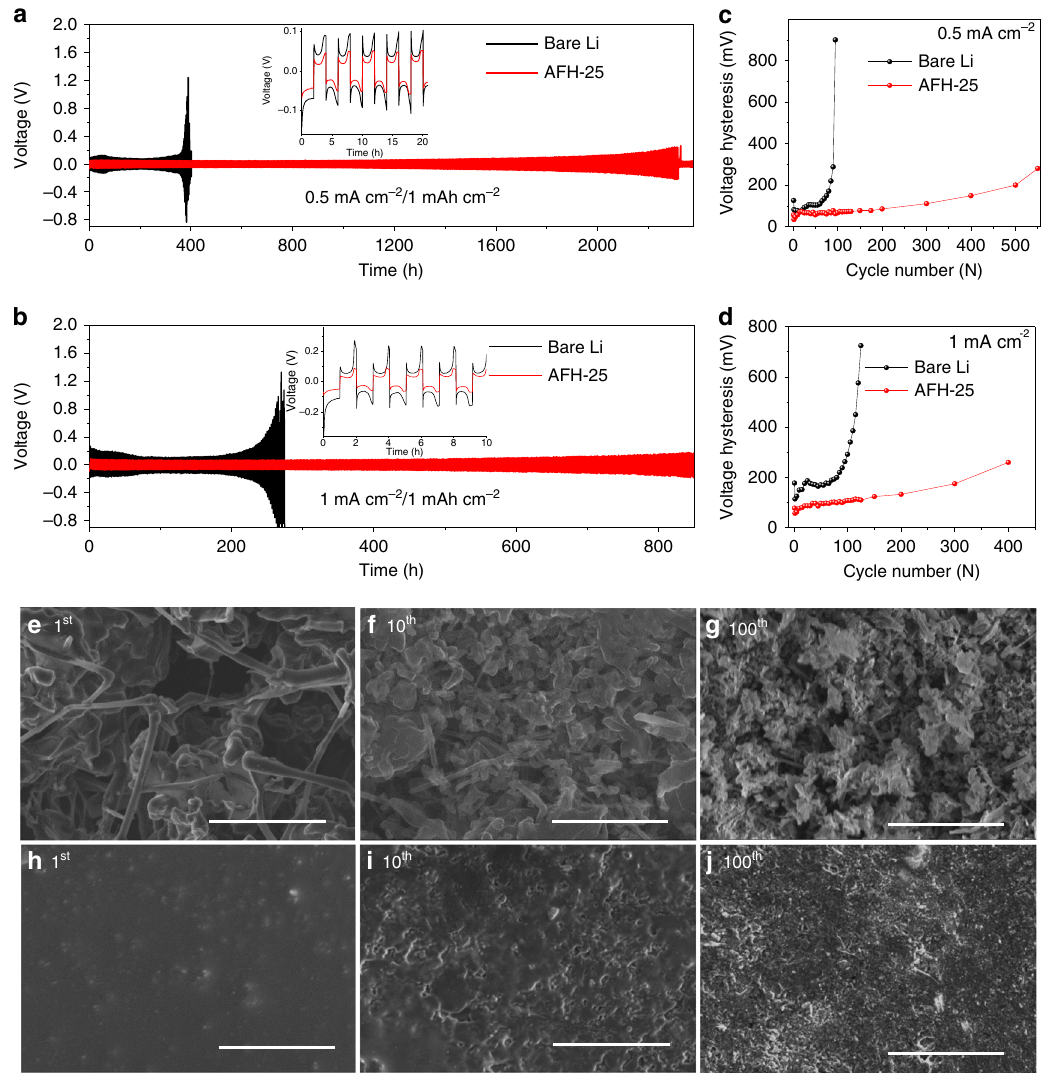
Fig. 5 Electrochemical symmetrical cell test and morphological analysis. a , b Plating/stripping voltage pro fi le of symmetrical cells at 0.5 mA cm − 2 and 1 mA cm − 2 , respectively. The insets are the fi rst fi ve plating/stripping cycles. c , d The corresponding average voltage hysteresis from a and b , respectively. e – j The SEM images of bare Li e – g and AFH-25 h – j at 1st, 10th, and 100 th plating, respectively. The scale bars are 20 μ